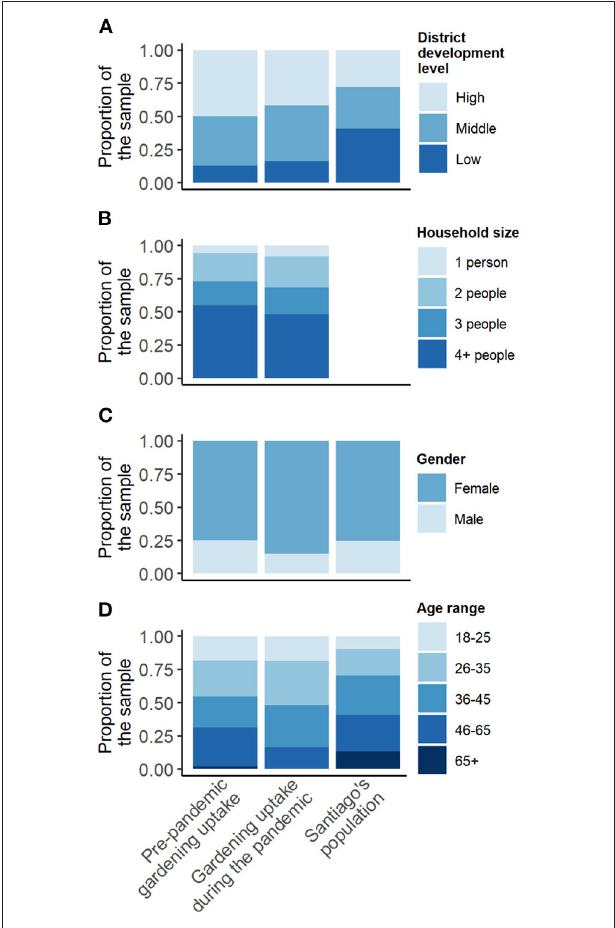
FIGURE 2 | Socio-demographic characteristics of the respondents according to whether they took up gardening pre- or during the pandemic, and in comparison to Santiago’s population. (A) District development level; (B) Household size, no data were available for Santiago’s population; (C) Gender; (D) age range, with the categories for Santiago’s population being slightly different, namely 20–24, 25–34, 35–44, 45–64, 65 + . There were no significant differences in the repartition of the population according to their time of gardening